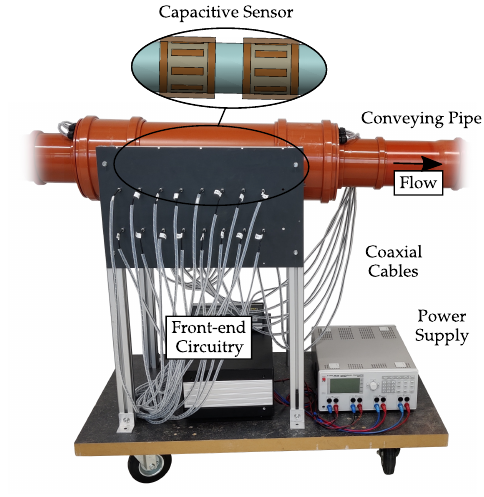
Figure 7. Capacitive measurement system for the determination of flow parameters in a pneumatic conveying laboratory test rig, which uses two sensors with eight electrodes